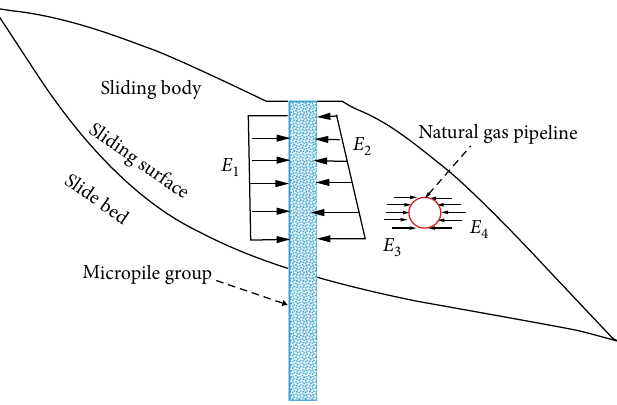
Figure 16: Simpli fi ed force diagram of micropile group-pipeline system.